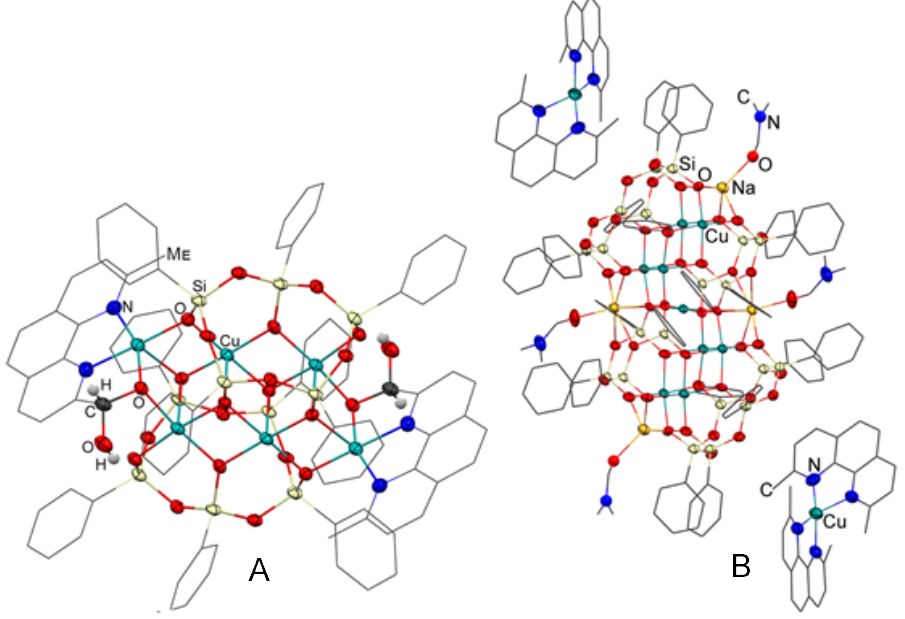
Figure 1. Features of cage Cu-CLMSs’ interaction with N , N -ligand (neocuproine). Left : Compound A with silsesquioxane and neocuproine ligands as parts of the same unit (Ref. [37]). Right : Ionic complex B with copper ions redistributed between silsesquioxane and neocuproine ligands (Ref. [38]). CLMS: cage metallasilsesquioxanes.